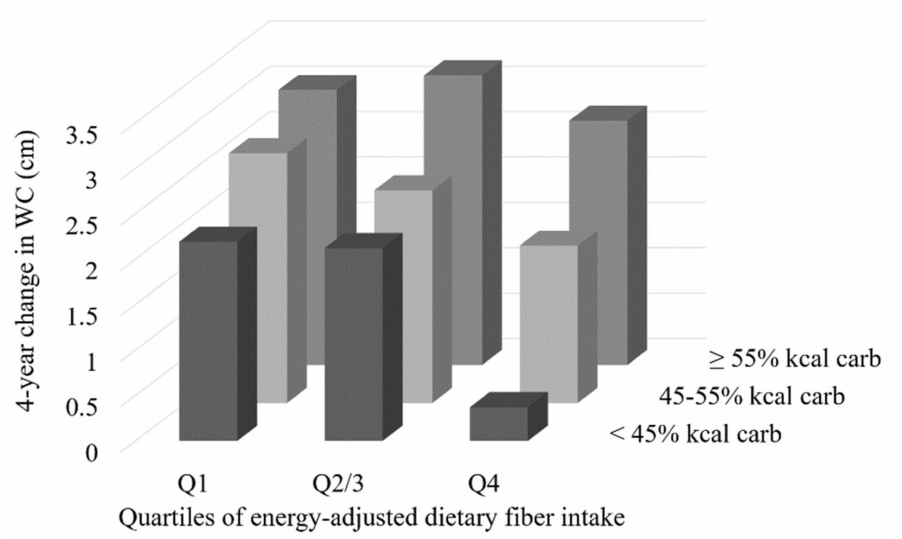
Figure 1. Combined association of total fiber and percent of energy from carbohydrate on mean four-year change in waist circumference (cm) in 3101 participants of the Framingham Cohort Study; Adjusted for age, sex, energy intake, periodic baseline WC, smoking status, physical activity score, alcohol, menopausal status, medication for diabetes, SFA (%kcal/d), and periodic baseline BMI; second and third quartile of fiber intake have been collapsed for visualization; BMI (body mass index); SFA (saturated fatty acids); WC (waist circumference). We also detected a significant interaction between total carbohydrate intake and BMI ( p < 0.001), but stratification by BMI did not reveal any statistically significant associations with WC (data not shown). No statistically significant associations were observed be- tween any of the carbohydrate quality measures and overall body weight (Supplementary Table